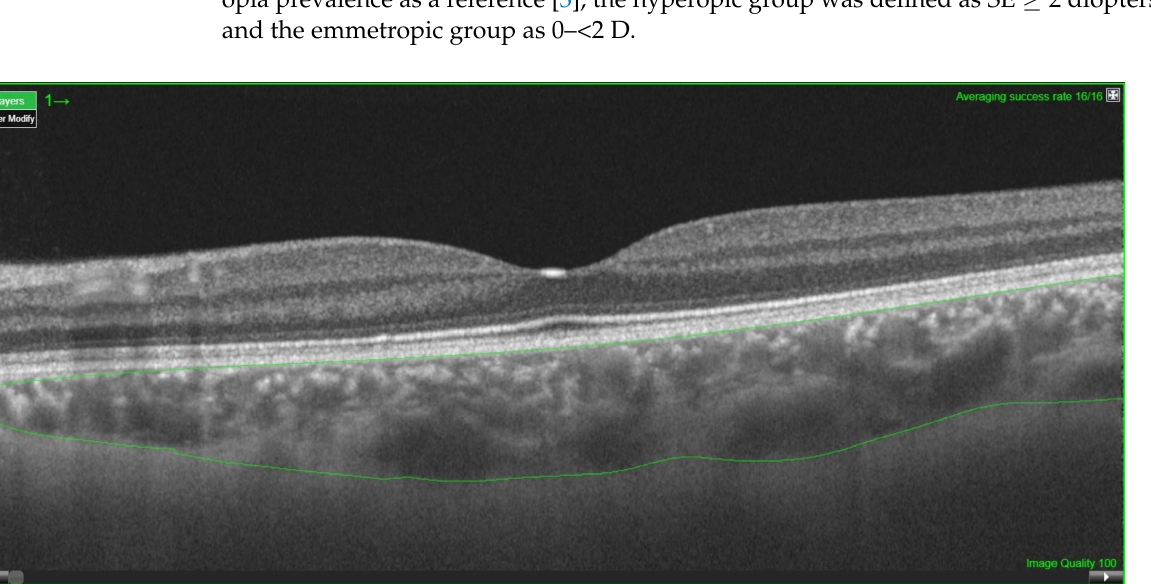
Figure 1. Macular OCT with 12-line radial scan and retina layers defined.